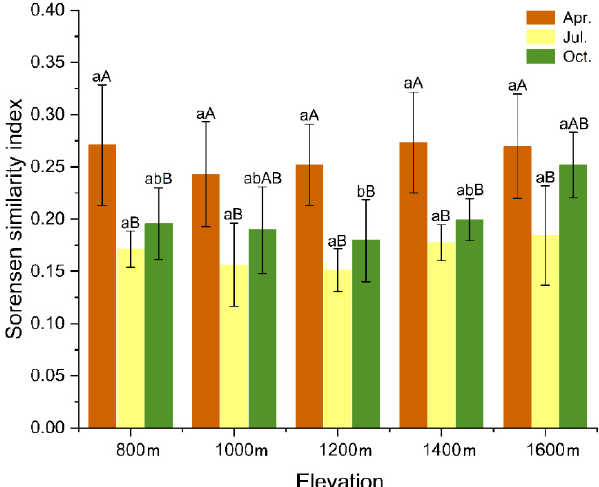
Figure 8. The Sørensen similarity index of different elevations and seasons. Different lowercase letters indicate significant differences ( p < 0.05) among different elevations in the same season, and different uppercase letters indicate significant differences ( p < 0.05) among different seasons at the same elevation (ANOVA and Tukey range test).